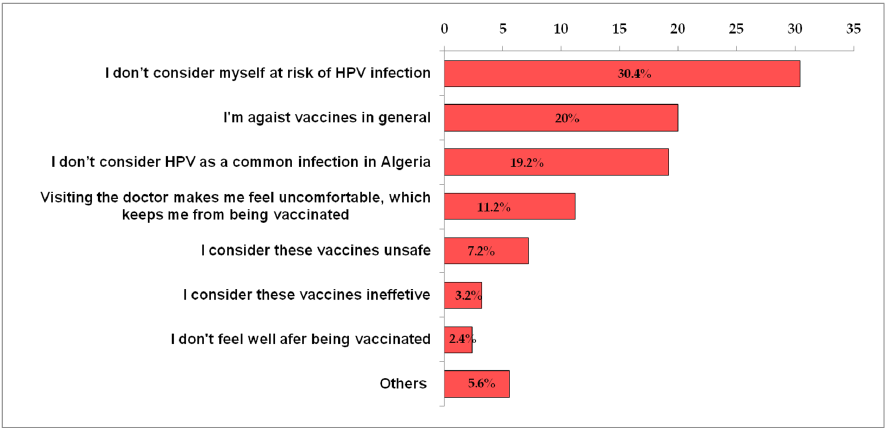
Figure 2. The distribution of responses to the questions evaluating HPV knowledge. * indicates correct responses.